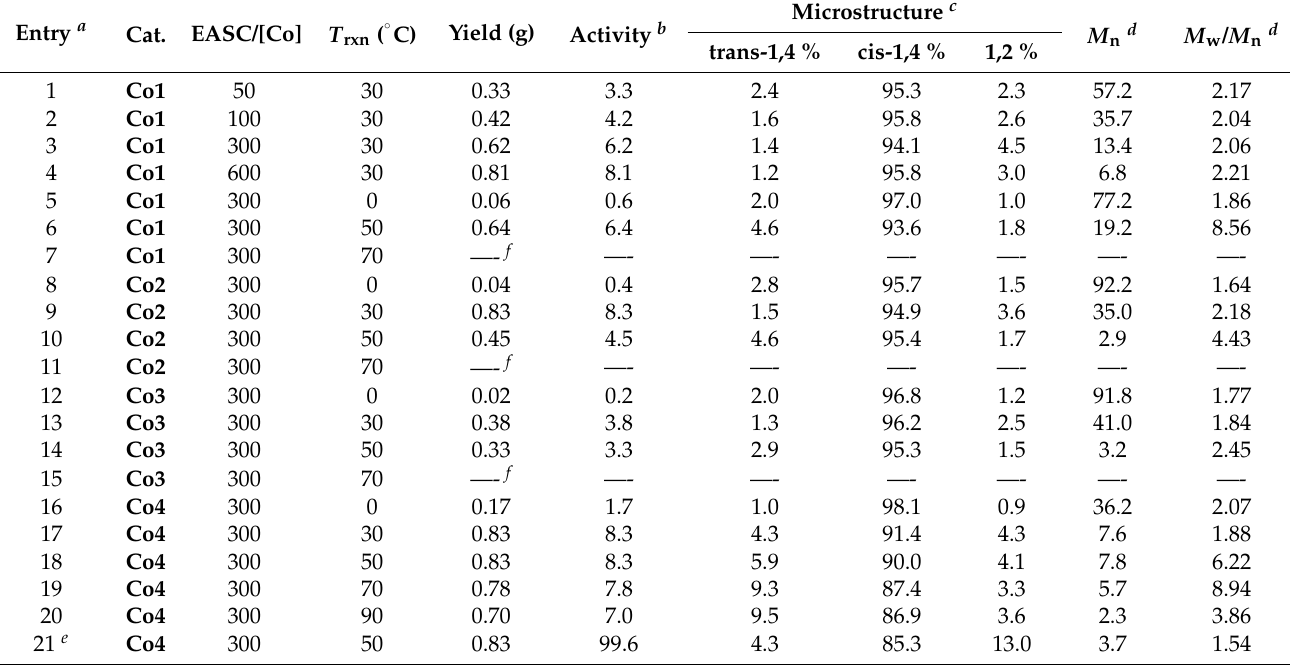
Table 1. Polymerization of 1,3-butadiene by cobalt complexes